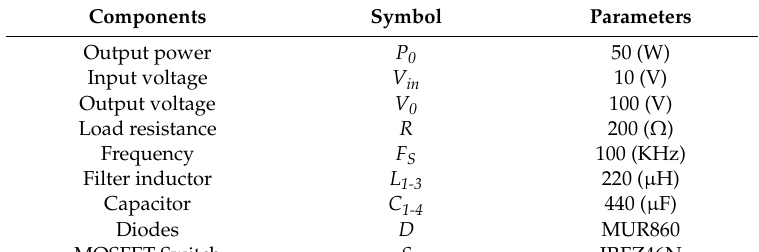
Table 1. Parameters for prototype.